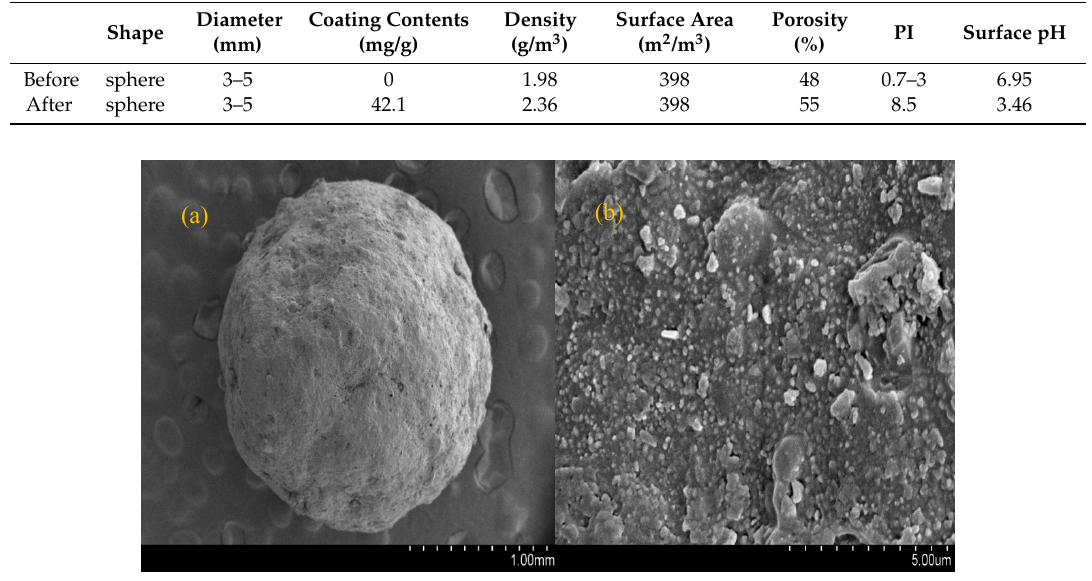
Figure 4. Scanning electron micrograph of commercial ceramsite: ( a ) 1 mm; ( b ) 5 µm.